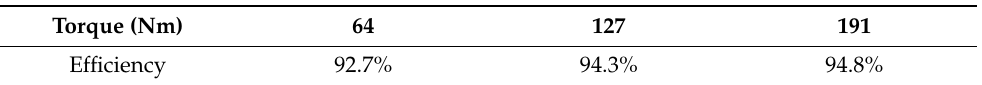
Table 2. Part load efficiency of the electric machine (inclusive of the driver). Torque (Nm)